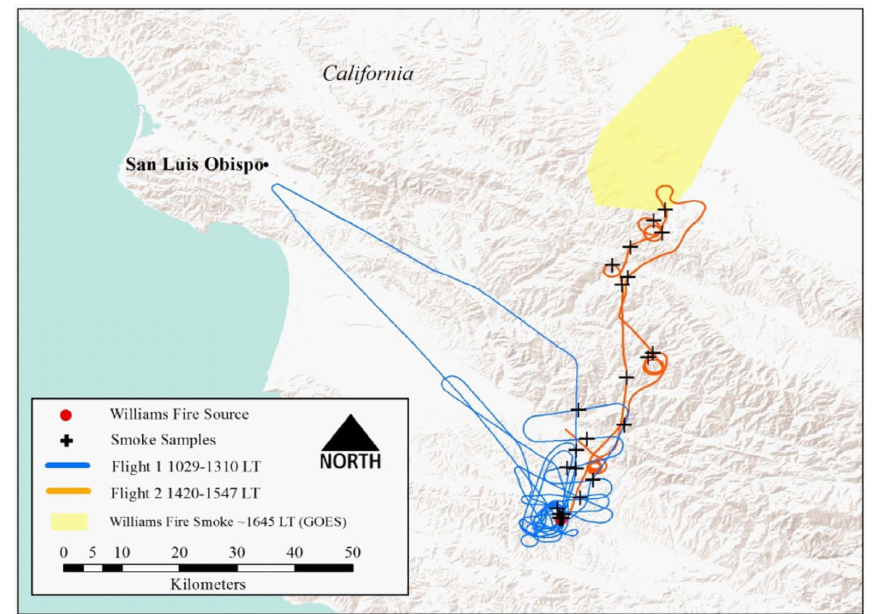
Fig. 3. The flight paths and the location of smoke samples for Flight 1 (blue) and Flight 2 (orange). The approximate position of the densest smoke in the Williams Fire plume (yellow) during the last daytime GOES image ( ∼ 16:45LT) captured after our second flight on 17 November 2009. The overlay shows that our measurements probed most of the daytime plume evolution that occurred on 17 November (plume image from